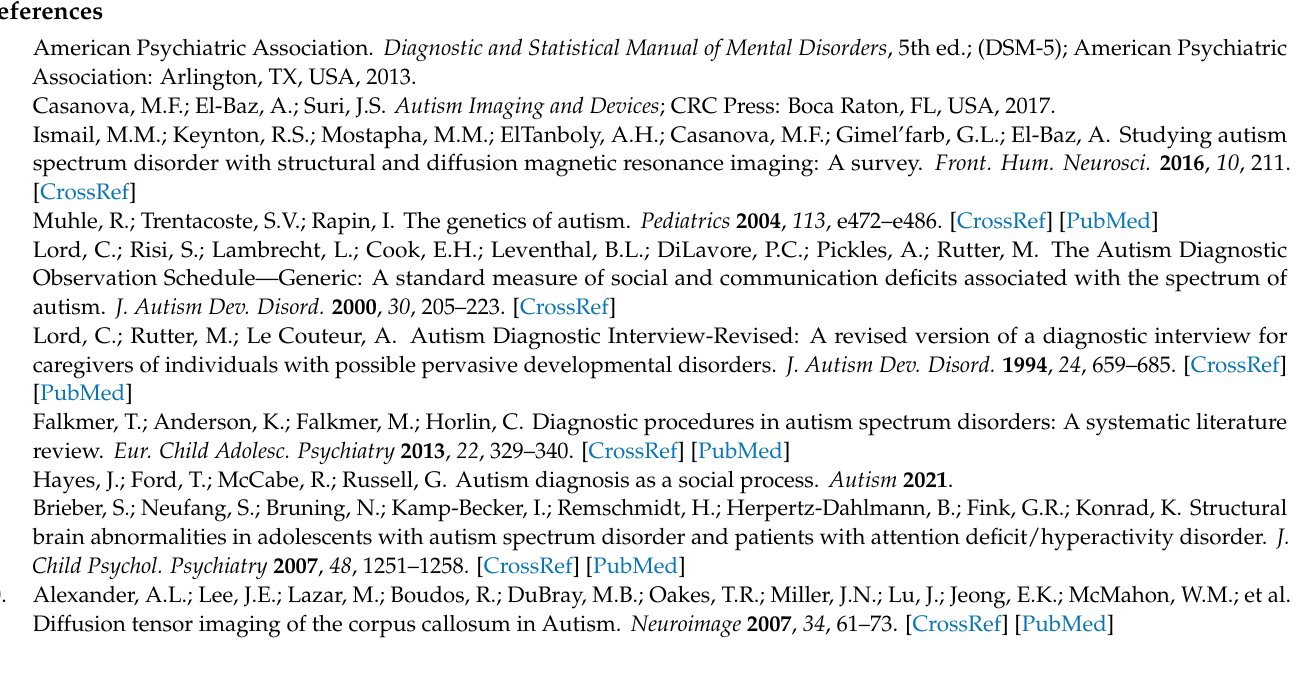
Supplementary Materials: The following are available at https://www.mdpi.com/article/10.3390/ Table S2: contains accuracy results for ˆ F representation, for different RFE-CV kernels. Table S3: subjects’ demographics: subject IDs, along with age, label, IQ, and gender, and also the summary of those demographics for each